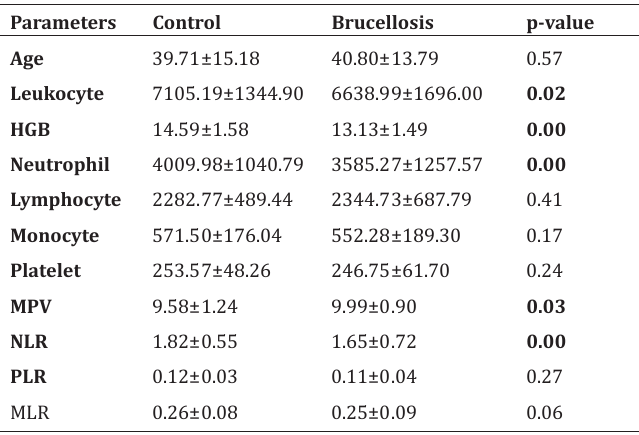
The results of the statistical analysis between brucellosis patients and the control group Parameters